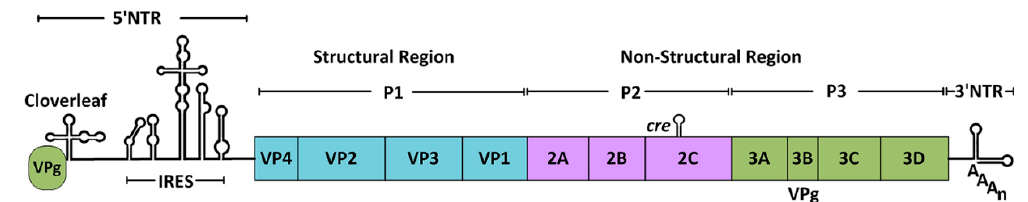
Figure 1. The entire genome structure of poliovirus (PV) [9]. This RNA genome contains a 5 ′ - nontranslated region (NTR), a large open reading frame, a 3 ′ NTR and a poly (A) tail. A small viral-encoded protein, 3B (VPg), is linked to the 5 ′ terminus of the RNA. The 5 ′ NTR consists of a cloverleaf structure and a type II internal ribosome entry site (IRES). The open reading frame encodes a single polyprotein comprising the structural protein P1 region and the non-structural protein P2 and P3 regions.